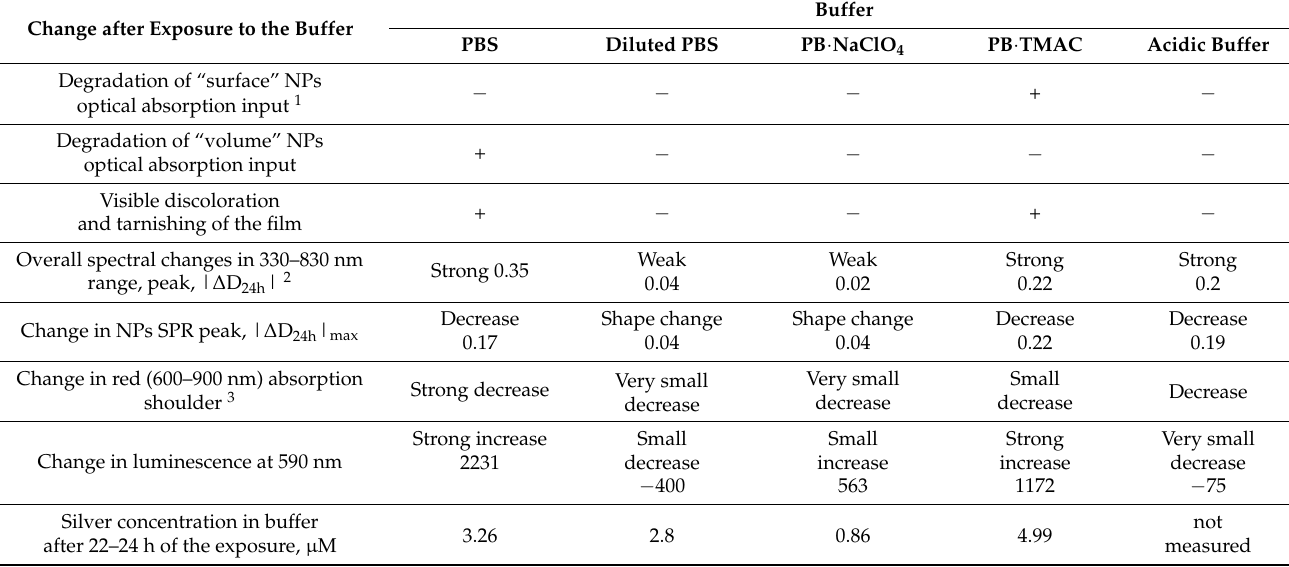
Figure 7. The luminescence spectra of Ag NPs-containing glass after exposure to different buffers. The excitation wavelength was 365 nm, the curves are marked according to the buffers ##, #0 cor- responds to the untreated sample. 3.3. Chemical Conversions The detailed mechanism of the chemical conversion of silver in the film needs fur- ther studies; however, some ideas may be proposed basing on qualitative behavior of the samples after exposure to various buffers. The driving force for the chemical conversion is the shift of Ag s ↔ Ag(I) + e − equilibrium by the stabilization of Ag(I) state by anions in